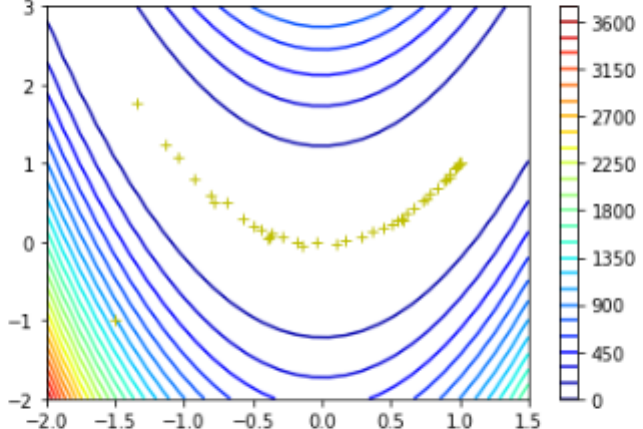
Figure 7. Global minima of the Rosenbrock function using BFGS algorithm. For the starting point x 0 = ( − 1.5, − 1 ) , the Rosenbrock function converges to x ∗ = [ 0.99999552, 0.99999103 ] T , with f ( x ∗ ) = 2.0060569721431806 e − 11 and ∇ q f ( x ∗ ) = [ 7.91549092 e − 07 , − 3.95920563 e − 07 ] T